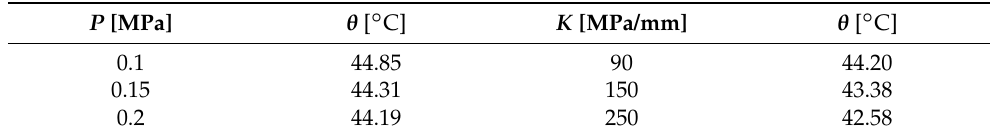
Table 6. Maximum temperature θ at the base of the microprocessor comparison for the uniform clamping pressure P and Winkler elastic supports stiffness K .